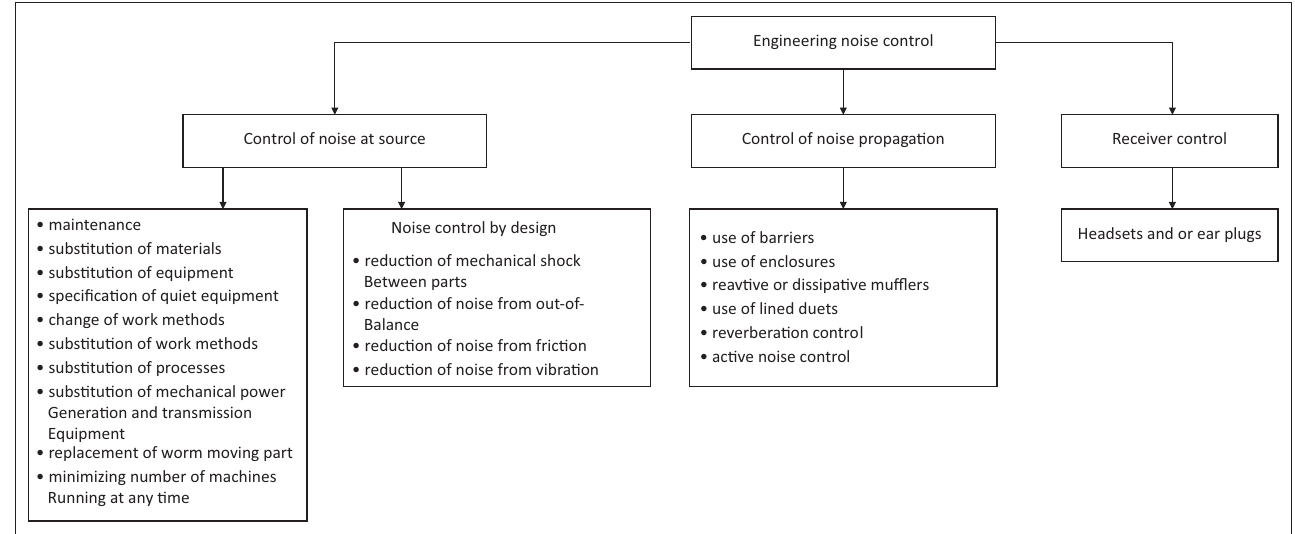
FIGURE 1: Seven pillars of an effective hearing conservation programme.